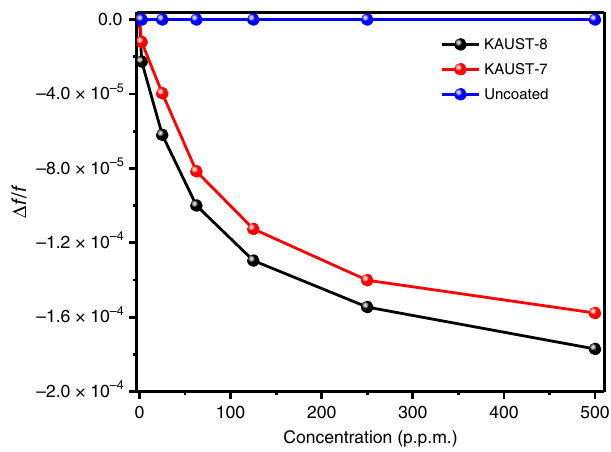
Fig. 6 Frequency shift comparisons. Frequency shift as a function of the SO 2 concentration for the uncoated and KAUST-7- or KAUST-8-coated QCM sensors